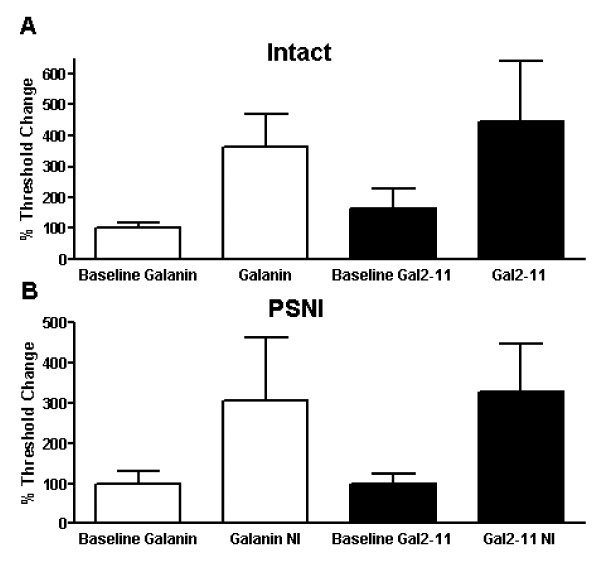
The effects of 10uM galanin and 10uM Gal2-11 on nociceptive C-fibres in intact and nerve injured rats. C fibre mechanical responses from intact and nerve injured rats after galanin treatment were normalised to baseline. [A] In intact naïve rats galanin and Gal2-11 were equipotent in increasing mechanical thresholds. [B] Similarly, three days after PSNI, galanin and Gal2-11 both equally increased mechanical thresholds.